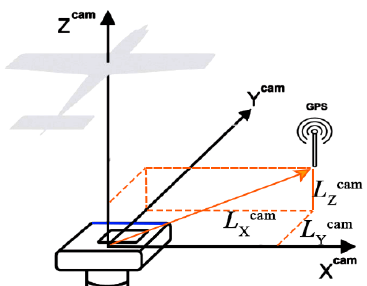
Figure 7. Camera reference system, as defined by Agisoft Metashape (the blu line on the camera denotes the camera top, which points towards the flying direction). The camera- antenna level arm offset L cam is represented with the orange arrow. Image adapted from Agisoft Metashape User Manual (Agisoft, 2021)